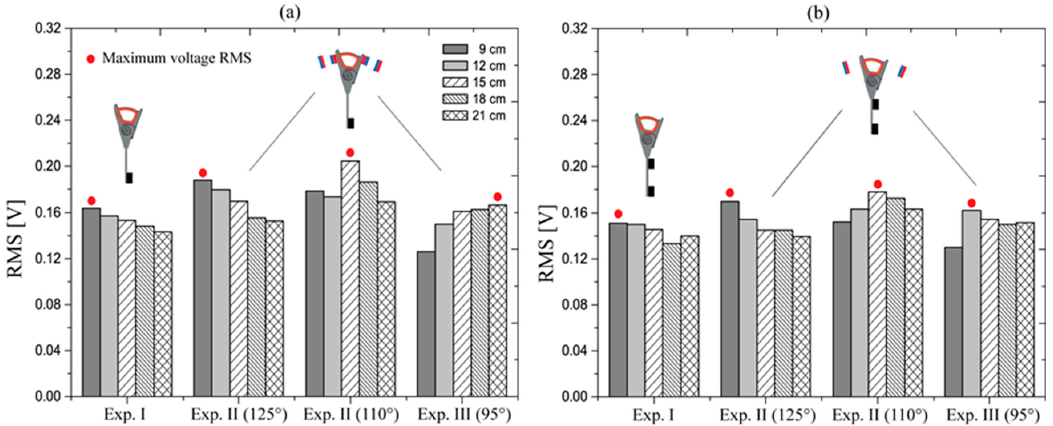
Figure 7. RMS voltage output for experiments I (inductive mode), II (magnets to 125°, 110°, and 95°): ( a ) One mass. ( b ) Two masses.